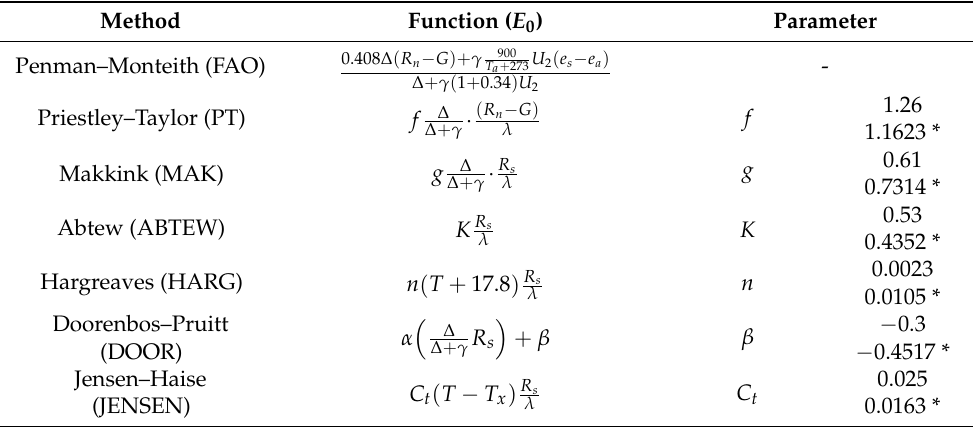
Table 3. E 0 estimation